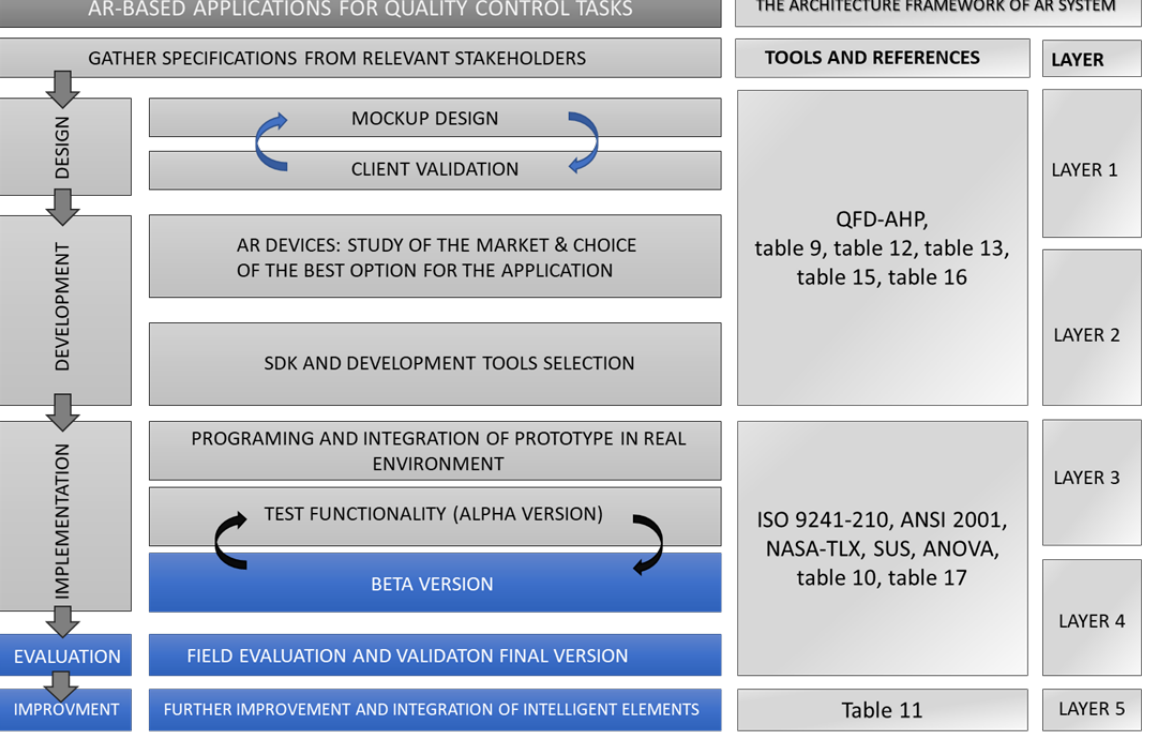
Figure 16. Methodology to design and develop long-term AR-based solution for quality sector adapted from [196].